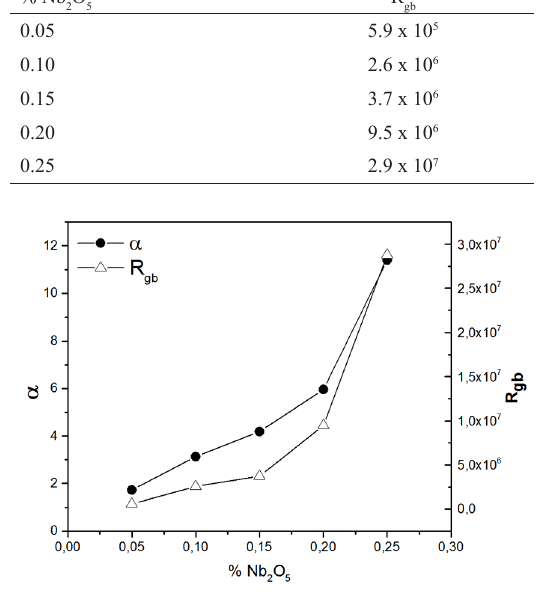
Figure 6. Nonlinear coefficient (left axis) and grain boundary resistance (right axis) as function of Nb